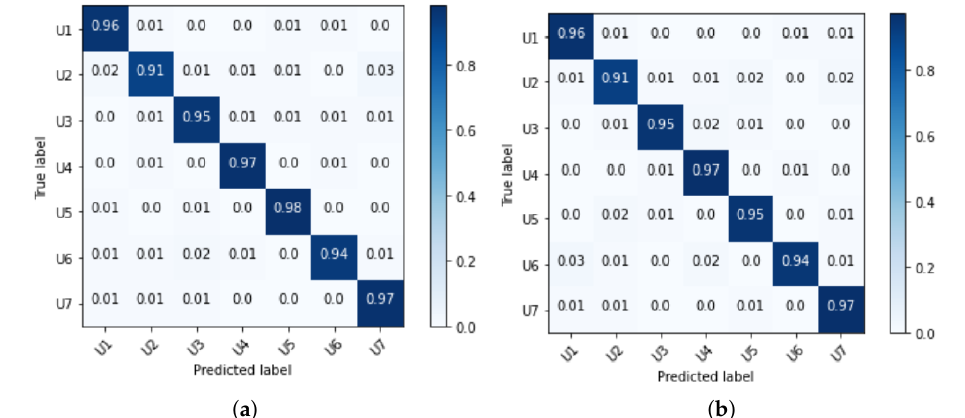
Figure 9. Mean normalized confusion matrix ( a ) for the left and ( b ) right carotid artery.